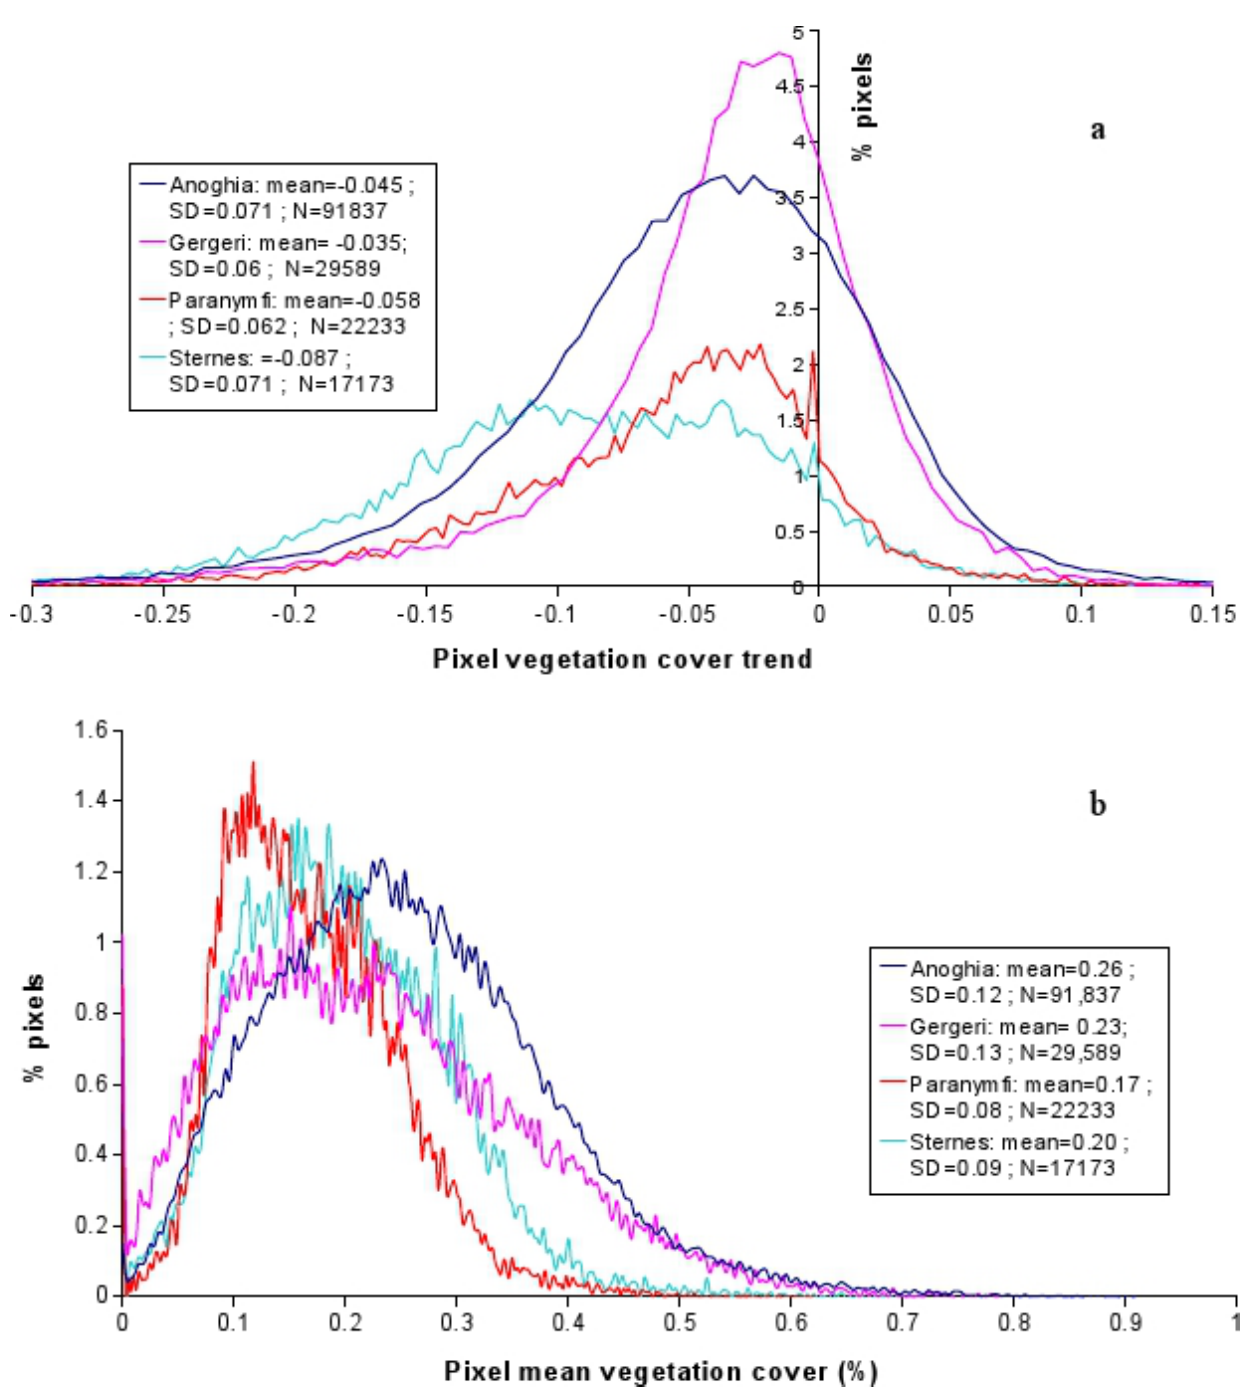
Figure 5. Vegetation-cover trend (a) and mean vegetation-cover distribution (b) in the four village